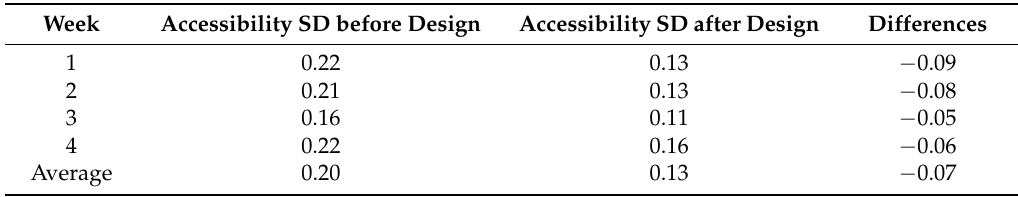
Table 1. Regional standard deviation (SD) of accessibility before and after the optimal design.